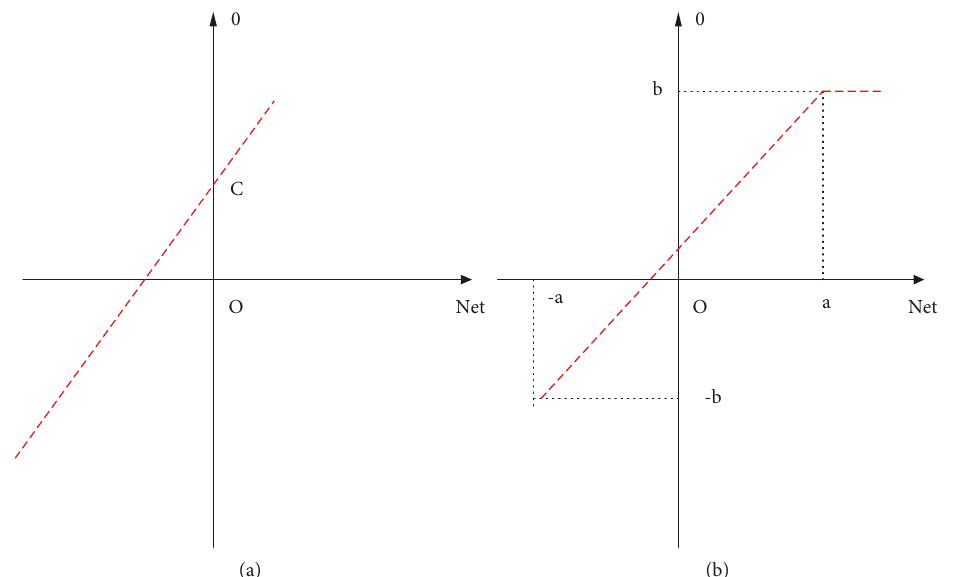
Figure 5: Typical excitation function: (a) linear function; (b) nonlinear function.